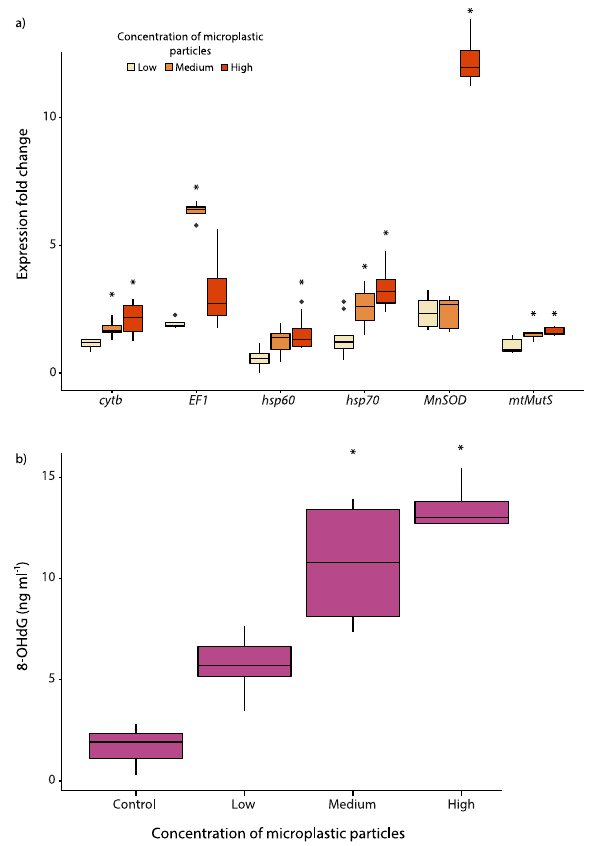
Fig. 5 Gene expression patterns and oxidative DNA damage in C. rubrum exposed to different levels of microplastic concentrations after 10 days of experimental incubation. a Expression fold change of six genes ( cytb, mtMutS, hsp70, hsp60, EF1, MnSOD ) obtained by real-time qPCR; b 8-hydroxydeoxyguanosine ( 8-OHdG ) levels obtained by ELISA. Average value and standard deviation (±) are reported. Signi fi cant differences for the expression of each gene and for 8-OHdG levels compared to the controls (corals not exposed to microplastics) are highlighted with asterisks: * P